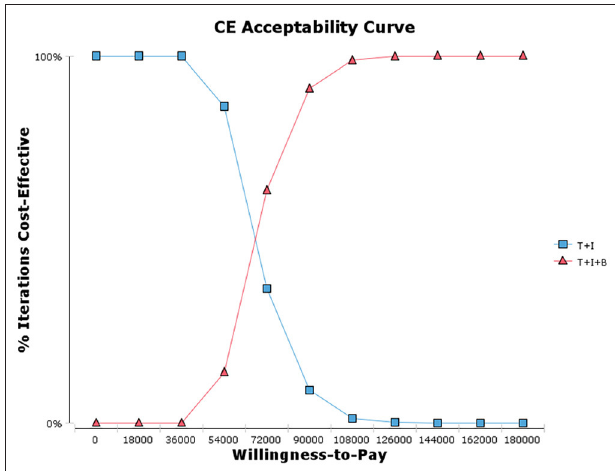
FIGURE 2 | Cost-effectiveness acceptability curves.